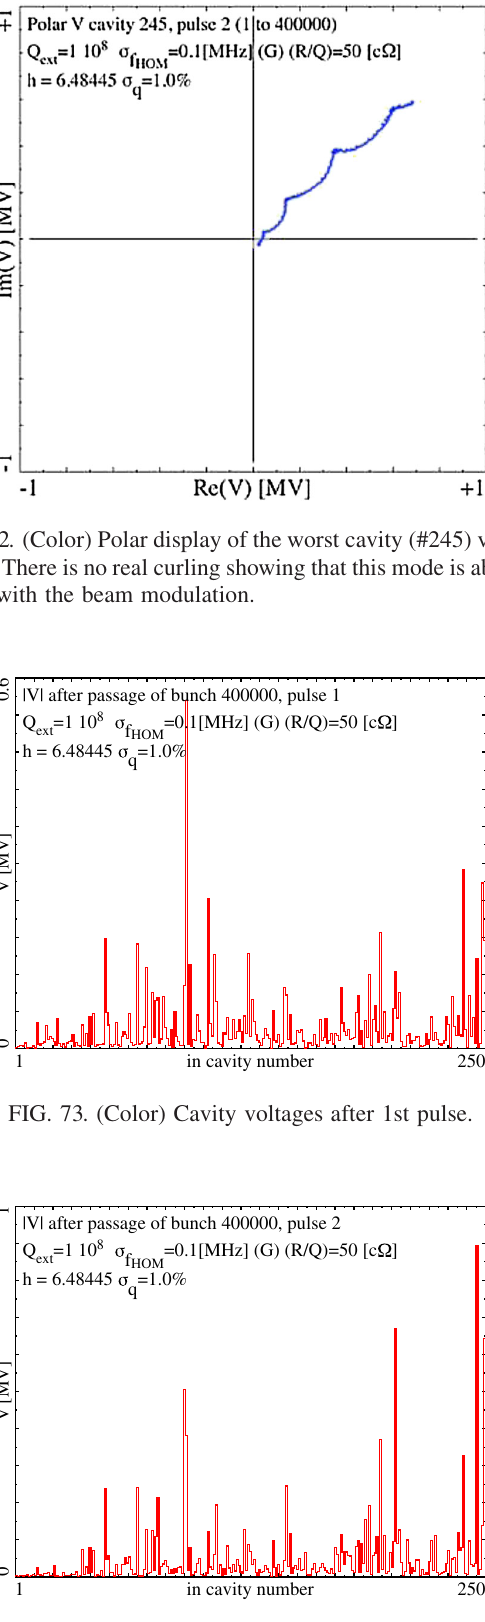
FIG. 74. (Color) Cavity voltages after 2nd pulse (identical to Fig. 9), The worst cavity is not the same one as for the 1st